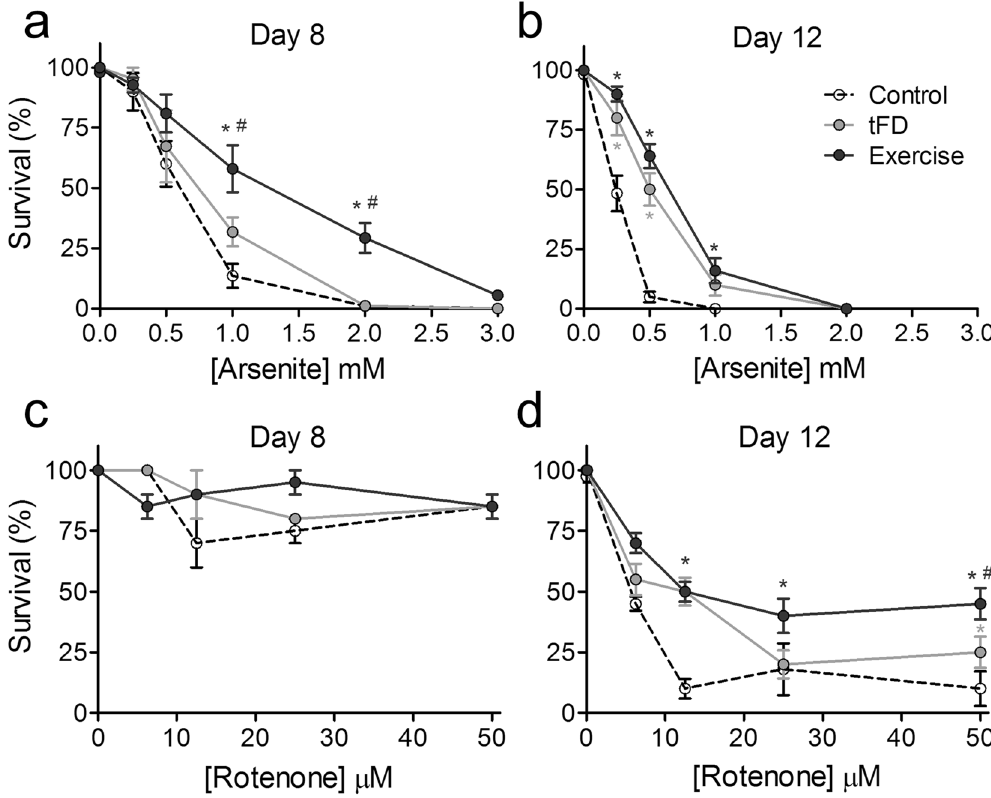
Figure 5. Exercise protects against lethality from exposures to arsenite and rotenone. Panels a and b represent 24-hour survival in varying concentrations of arsenite for day 8 and day 12 animals, respectively. Panels c and d are 24-hour survival of day 8 and 12 nematodes, respectively, in rotenone. For experiments, 10 nematodes were picked into a 96-well plate in duplicate wells for each dose. Exposures were carried out for 24 hours, following which survival was assessed by a harsh touch with a platinum wire. Data shown are the average of three biological replicates. For individual traces see Supplementary Information, Figs S3 and S4. Statistical significance was assessed by a two-way ANOVA followed by a Bonferroni posttest comparing all groups to each other. Significance is indicated by an asterisk * if the data are significantly different, p < 0.05, compared to the control group and a symbol # if the data are significantly different, p < 0.05, compared to the tFD group. For analysis of LC 50 curves, see Tables 1 and 2.